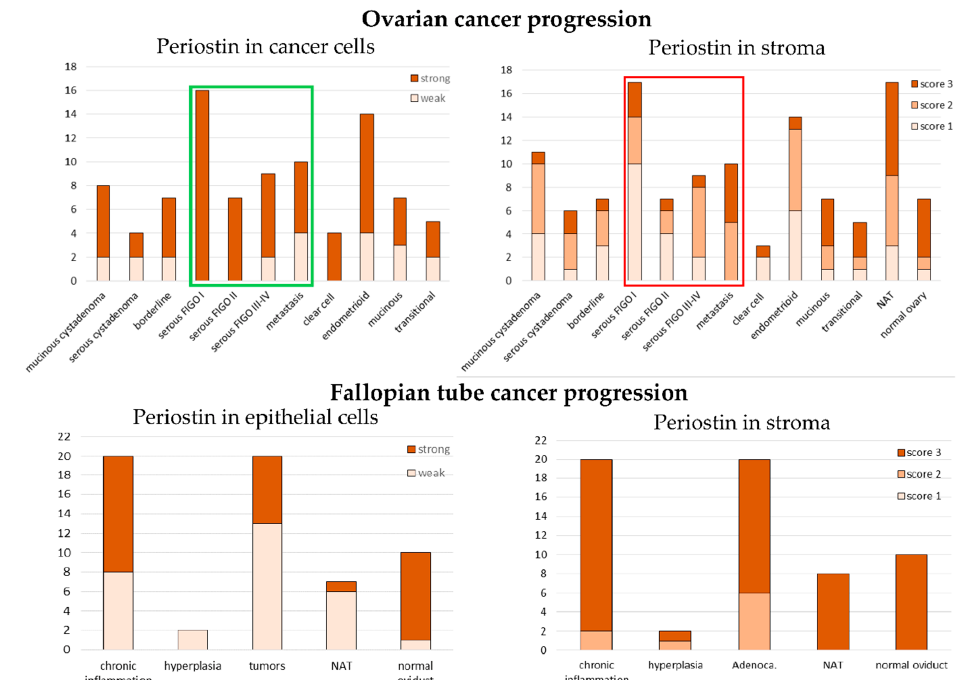
Figure 8. Expression of periostin in tissue arrays. The y axis represents the number of samples. NAT—normal tissue adjacent to the tumor.